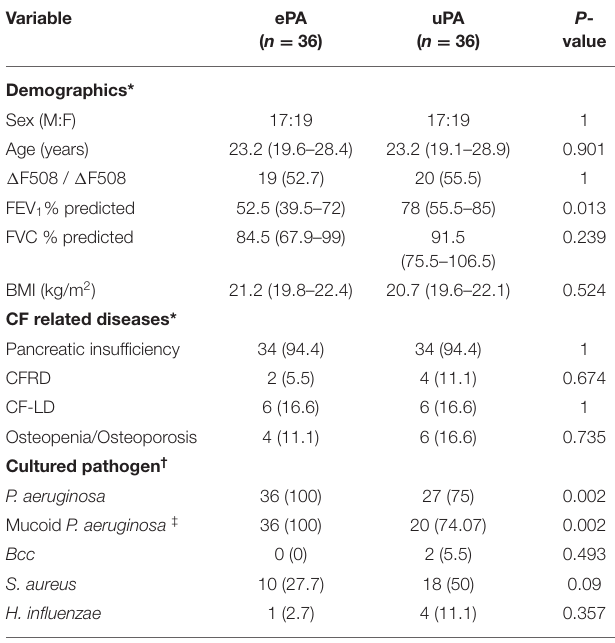
TABLE 1 | Baseline characteristics of ePA and uPA